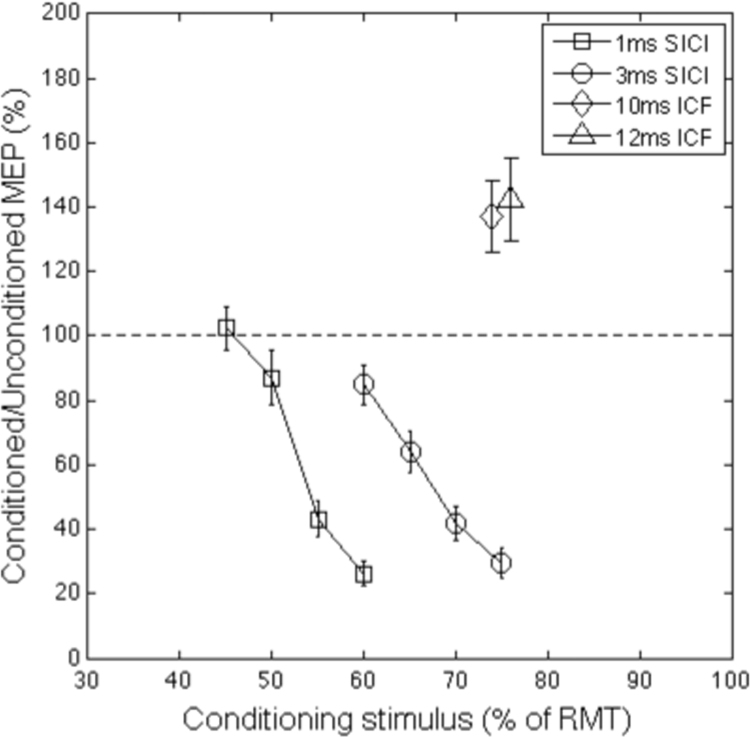
Group mean of individual median MEP values for paired pulse SICI (1 ms and 3 ms ISI) and ICF (10 ms and 12 ms ISI) trials. Error bars represent the standard error of the mean.